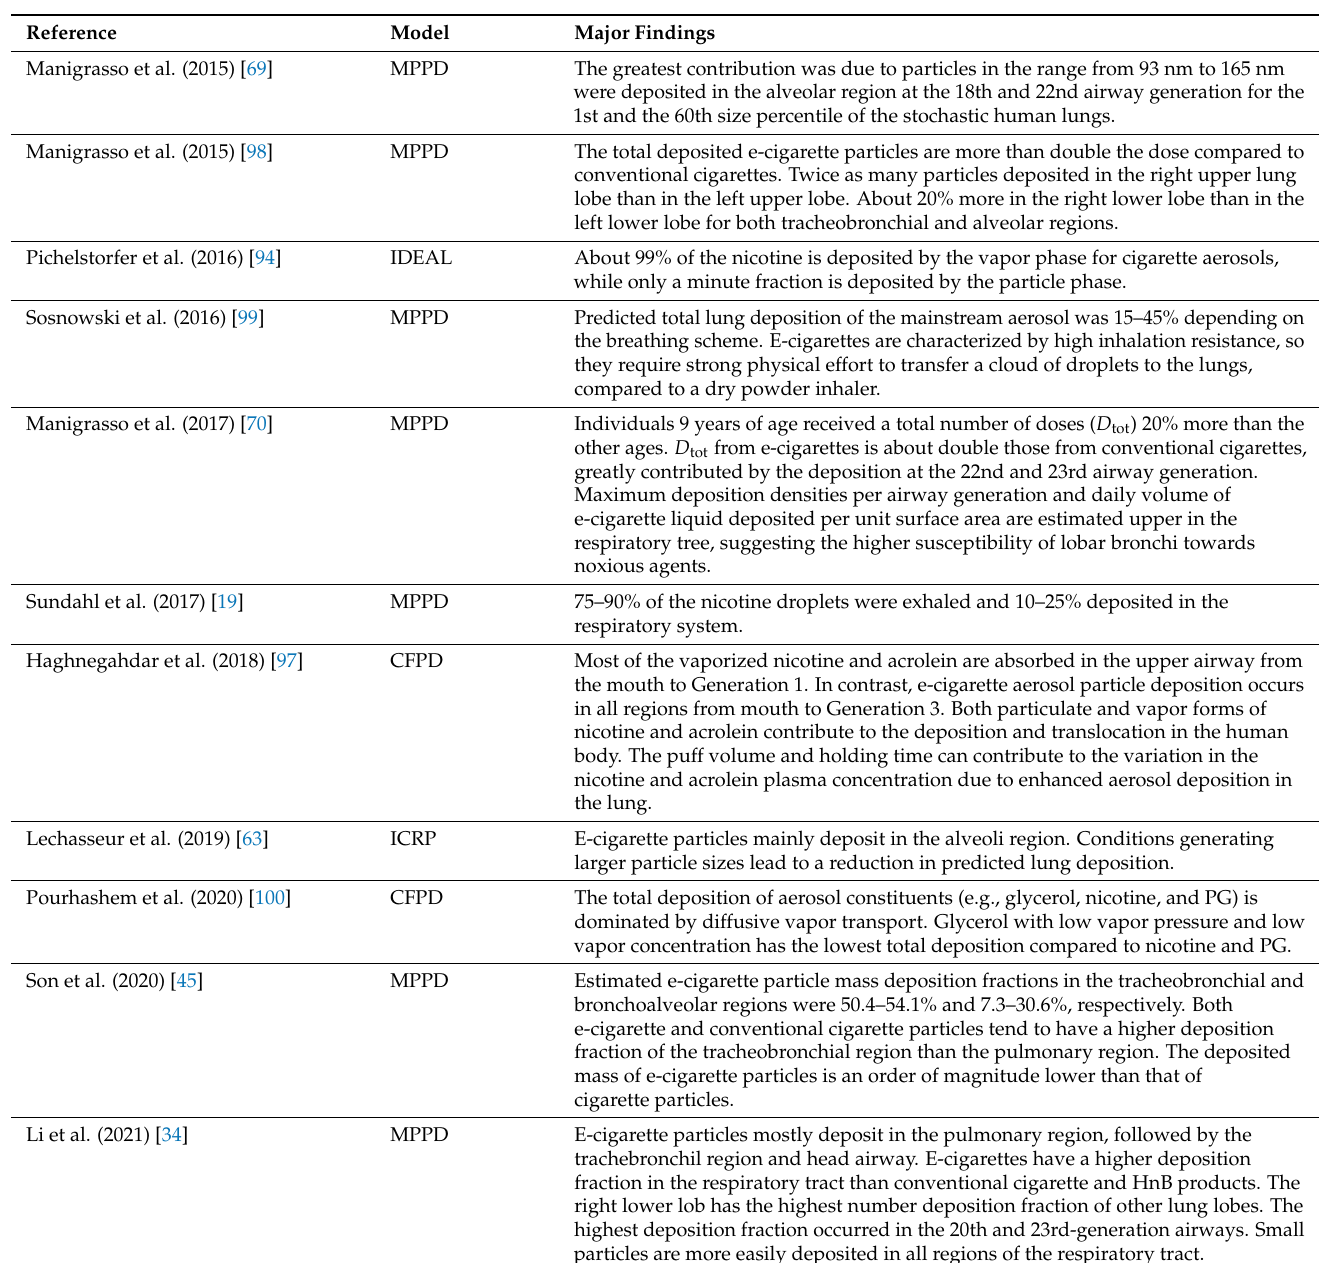
Table 3. The modeling results of studies published after